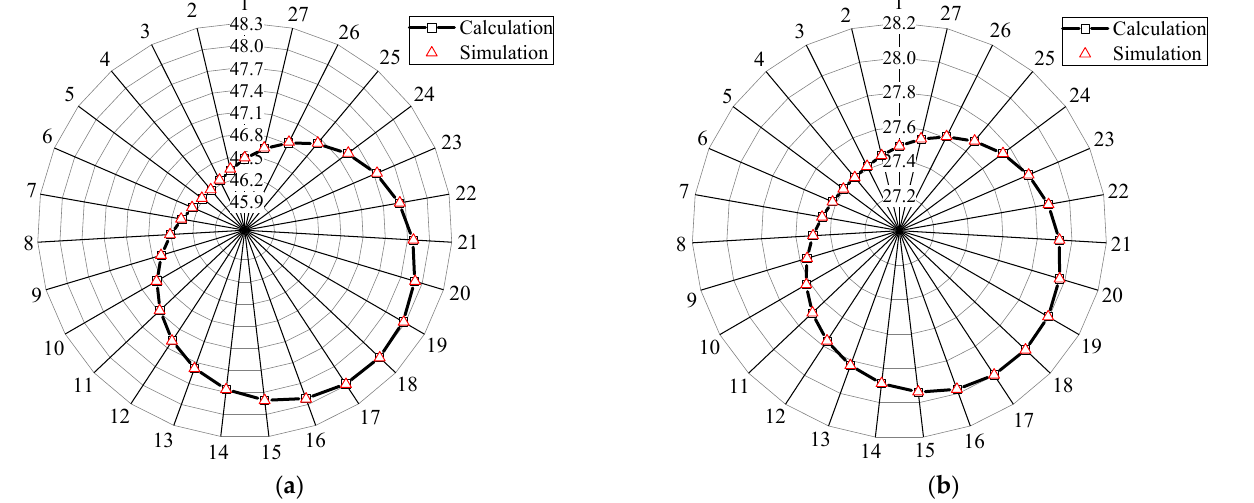
Figure 11. Velocity distribution of thrust cylinders (unit: mm/s). ( a ) t = 10 s. ( b ) t = 30 s.